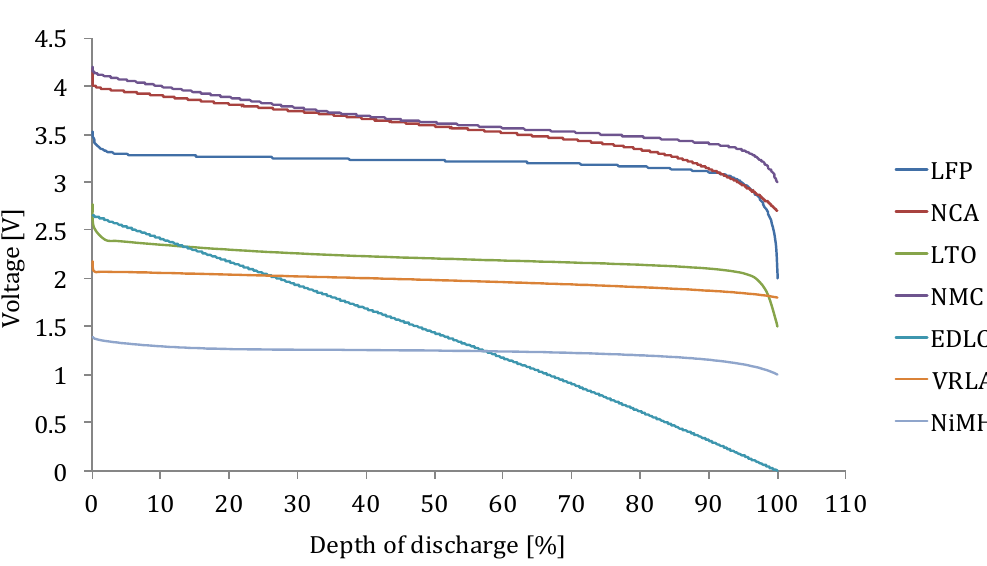
Figure 17. Voltage versus depth of